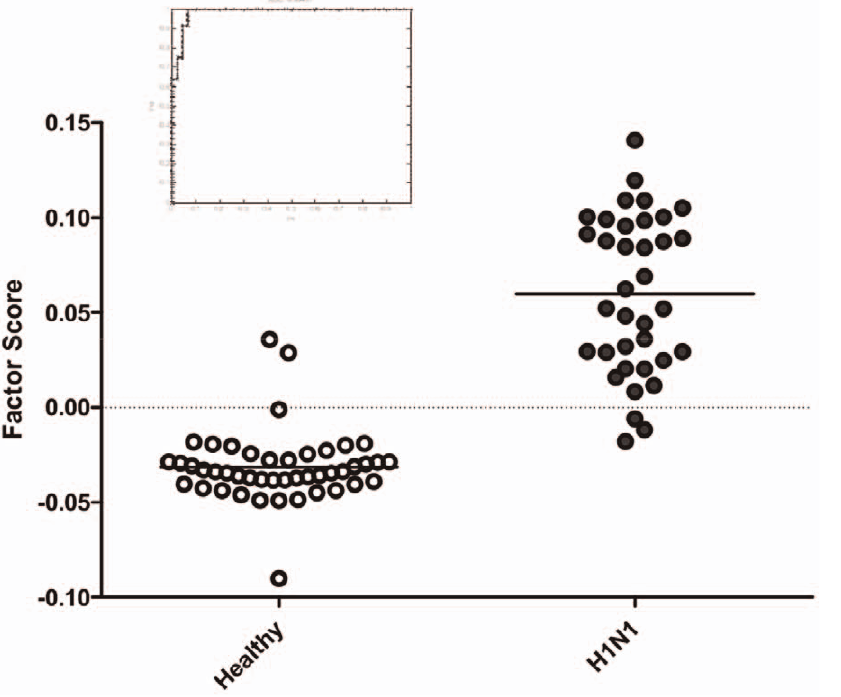
N ) from healthy individuals ( # ) as